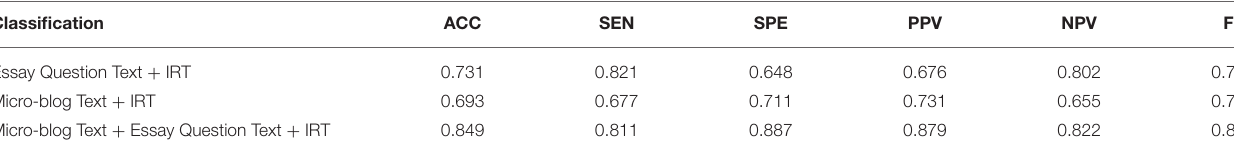
TABLE 7 | The results of the three models in text–IRT classification. Classification ACC SEN